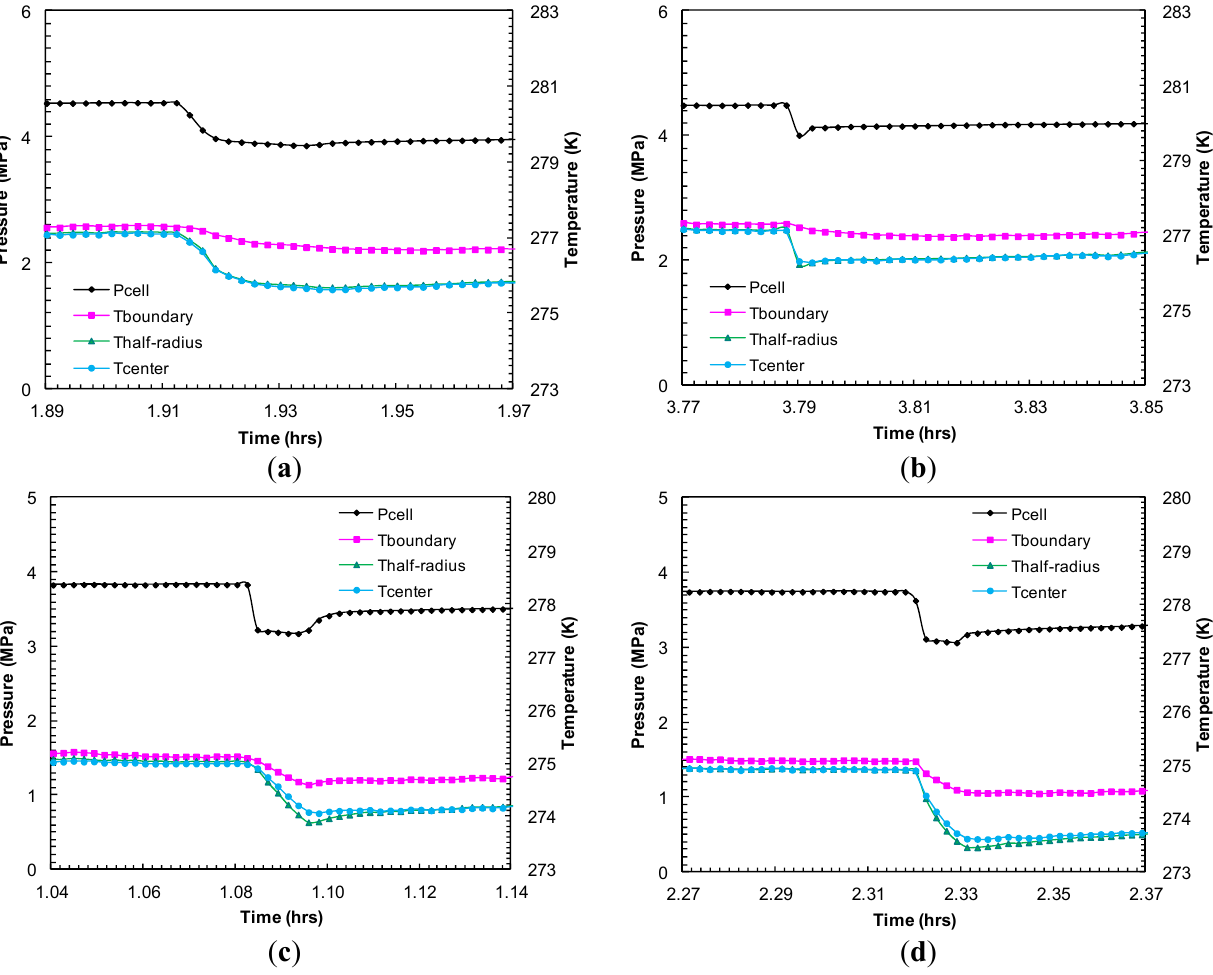
Figure 9. Thermocouple responses at various locations within sand-pack (center, half radius, sand-pack boundary) during dissociation with successive pressure drops: ( a ) dp2 = 0.69 MPa; and ( b ) dp3 = 0.92 MPa from Experiment 2; ( c ) dp2 = 0.66 MPa; and ( d ) dp3 = 0.68 MPa from Experiment